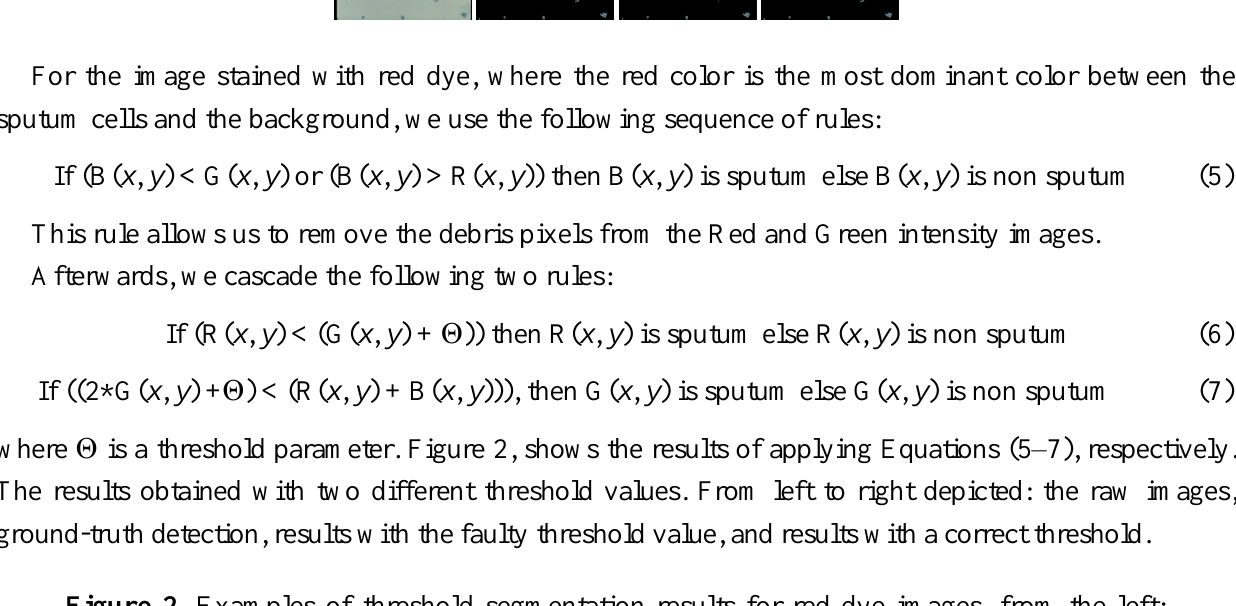
Figure 2. Examples of threshold segmentation results for red dye images, from the left: raw images, ground-truth data, detection obtained with a faulty threshold, detection obtained with a correct